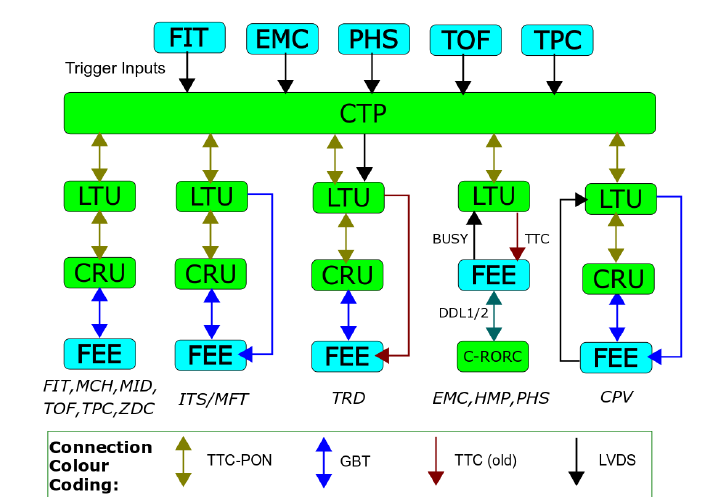
Figure 1. Central Trigger System overview showing trigger inputs to the CTP and the connection types between the CTP and the detector FEE.